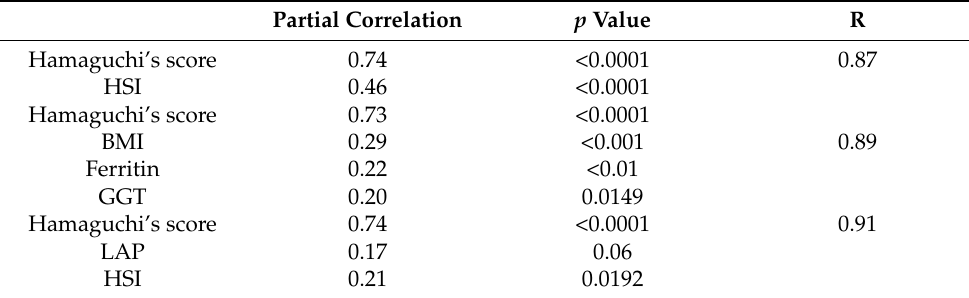
Table 4. Optimal steatosis predicting